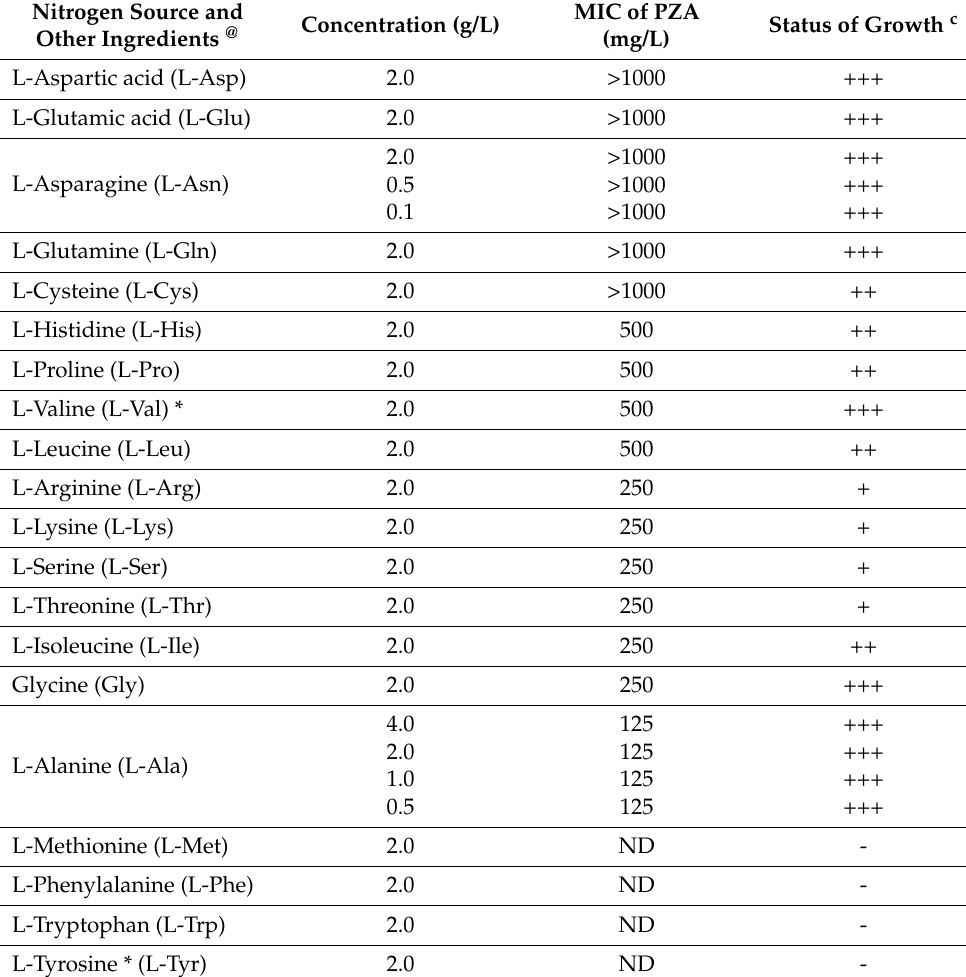
Table 1. MICs of PZA and growth of M. tuberculosis were determined at pH 6.8 in different minimal media at 37 ◦ C for 20 days with the microdilution broth method. Nitrogen Source